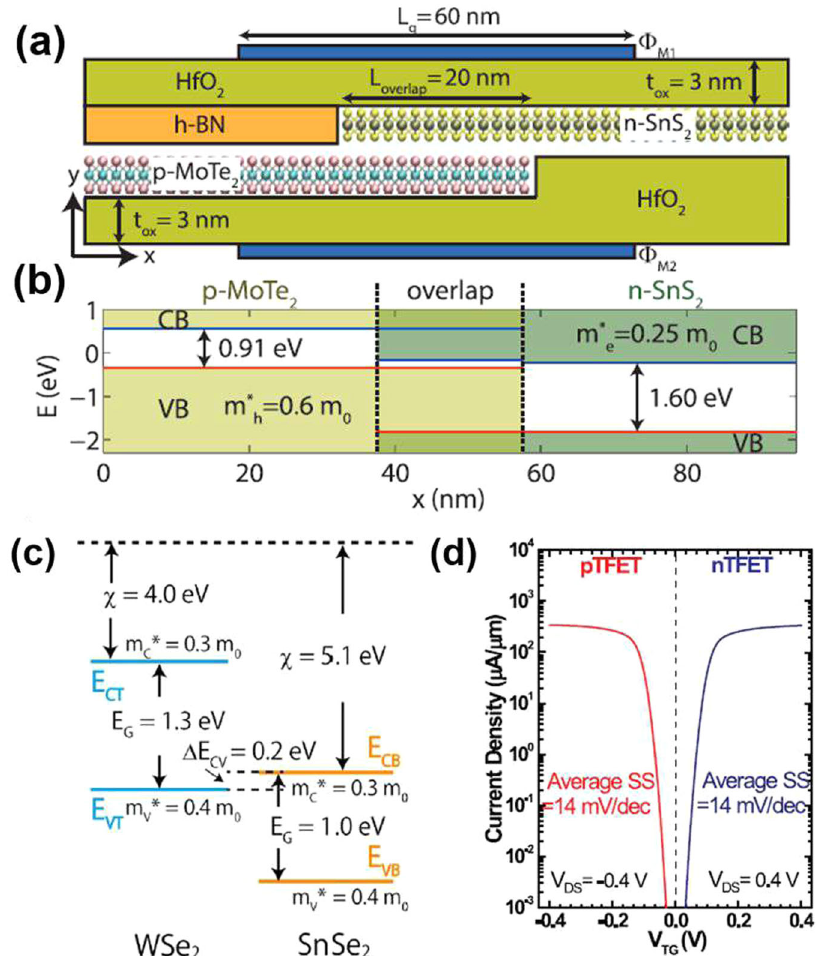
Fig. 24 Simulation Report of Nanoscale 2D vdW-TFET. a Device schematics and b band alignment in MoTe 2 /SnS 2 vdW hetero-junction adapted with permission from 118 . Copyright (2015) IEEE, c band alignment, d transfer characteristics of band alignment in WSe 2 /SnSe 2 vdW- TFET, adapted with permission from 129 . Copyright (2015)